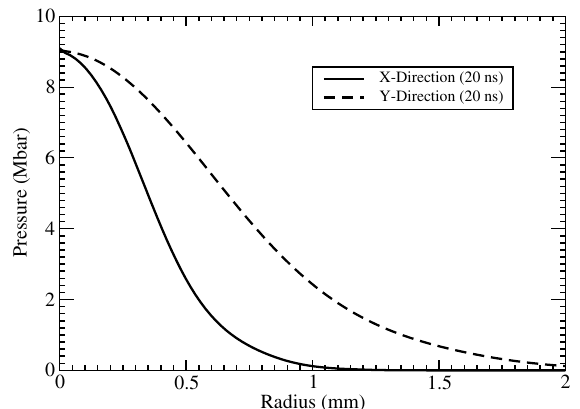
FIG. 21. Pressure vs radius corresponding to the case shown in Fig. 20.